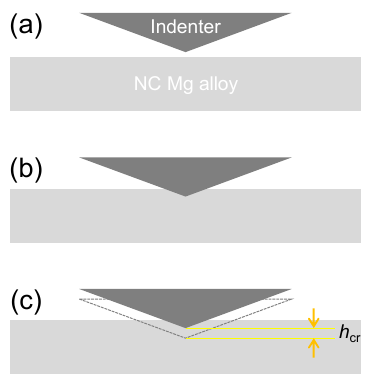
Figure 1. Diagram showing the interaction between indenter and material surface: ( a ) before loading, ( b ) during loading, and ( c ) holding stage.